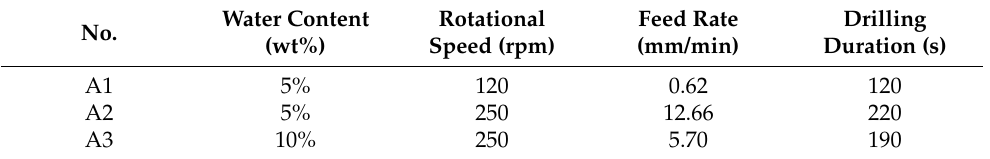
Table 4. Drilling parameters.